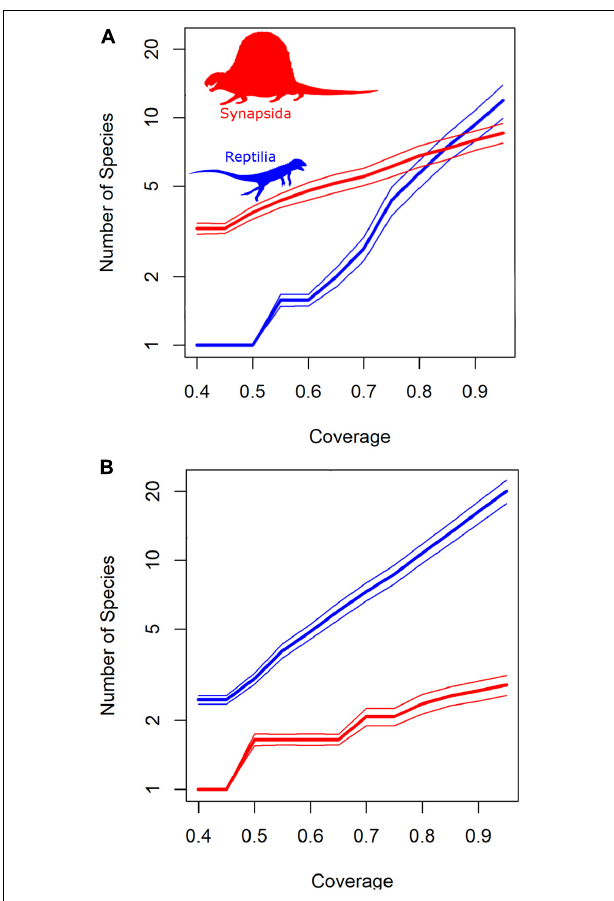
FIGURE 4 | Diversity of reptiles and synapsids within Richards Spur. Thick lines represent diversity estimate of reptiles (blue) and synapsids (red) when subsampling to a particular coverage. (A) Taxonomic scheme 1; (B) Taxonomic scheme